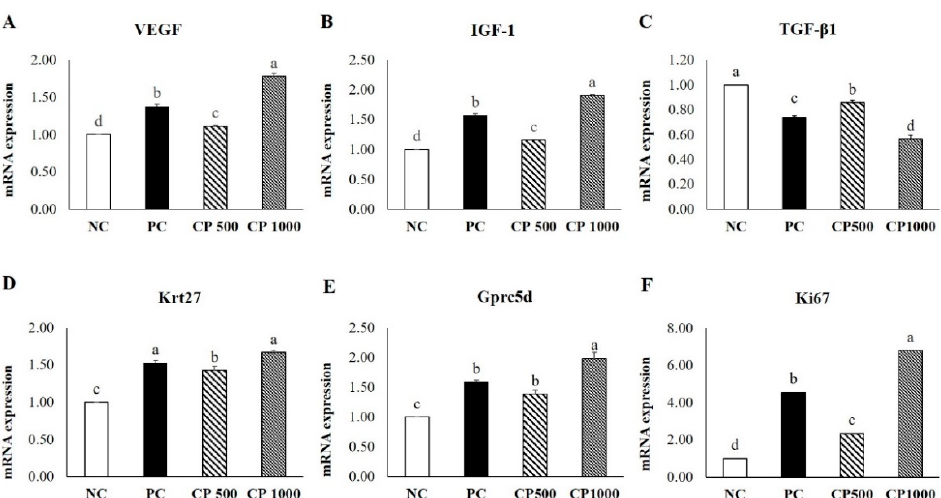
Figure 6. Results of RT-qPCR. Effect of hair regrowth on depilation-induced C57BL/6 mice orally treated with CP (500 mg/kg and 1000 mg/kg, respectively) for 6 weeks. ( A ) VEGF; ( B ) IGF; ( C ) TGF- β 1; ( D ) Krt27; ( E ) Gprc5d; ( F ) Ki67. Values with different superscript letters are significantly different ( p < 0.05). Results are the mean ± SE ( n = 8/group). NC: negative control (distilled water), PC: positive control (finasteride, 1 mg/kg); CP500: collagen peptide, 500 mg/kg; CP1000: collagen peptide, 1000 mg/kg.